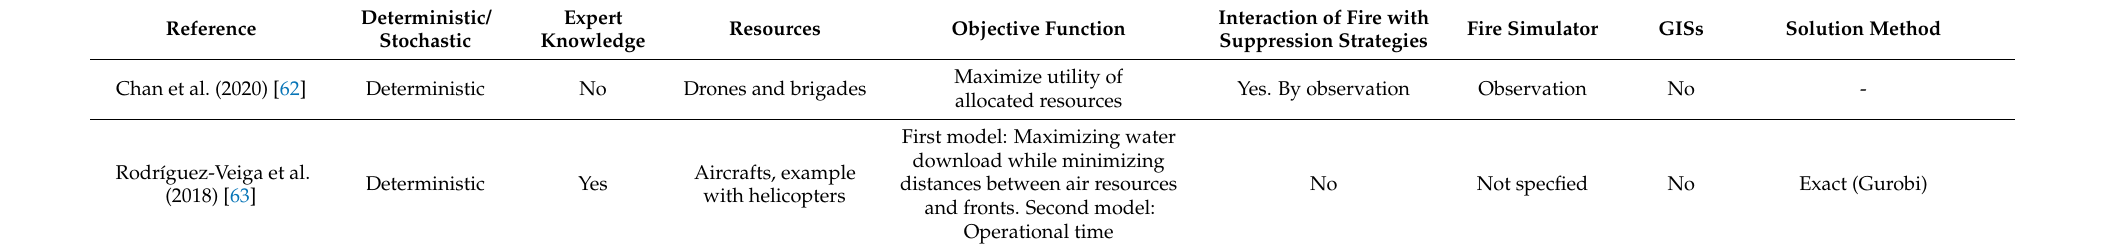
Table A6. List of main characteristics of papers that address the dispatch of resources for response. Other